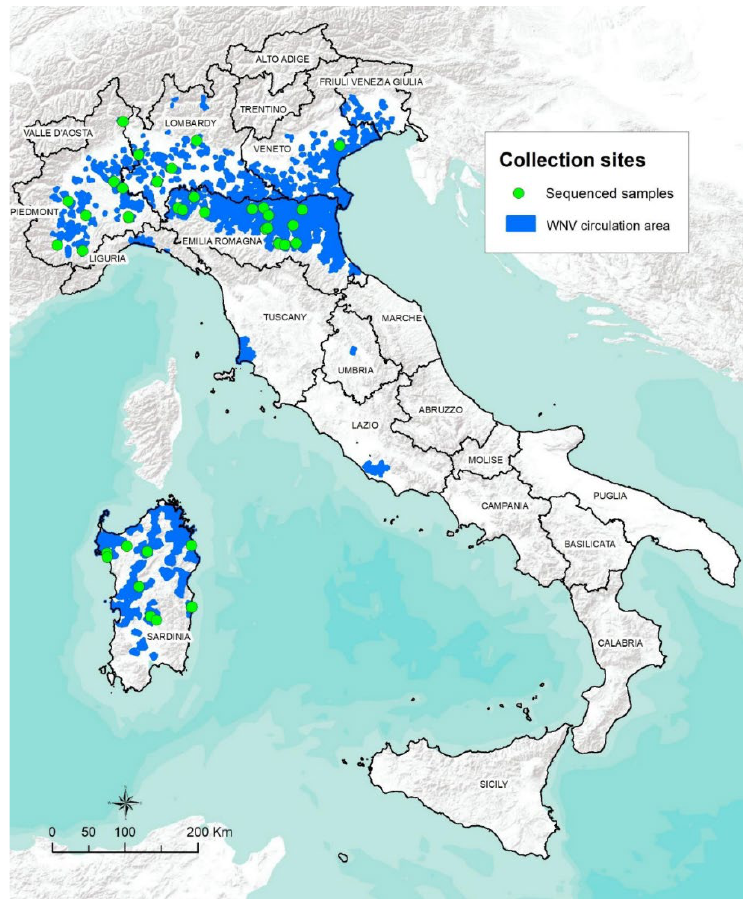
Figure 1. Geo-localization of WNV L2 sequenced sample collection sites. In blue, the WNV L2 circulation municipalities obtained from veterinary sample collection performed between 2011 and 2021 are displayed. The collection sites of samples from which sequences were obtained are shown in